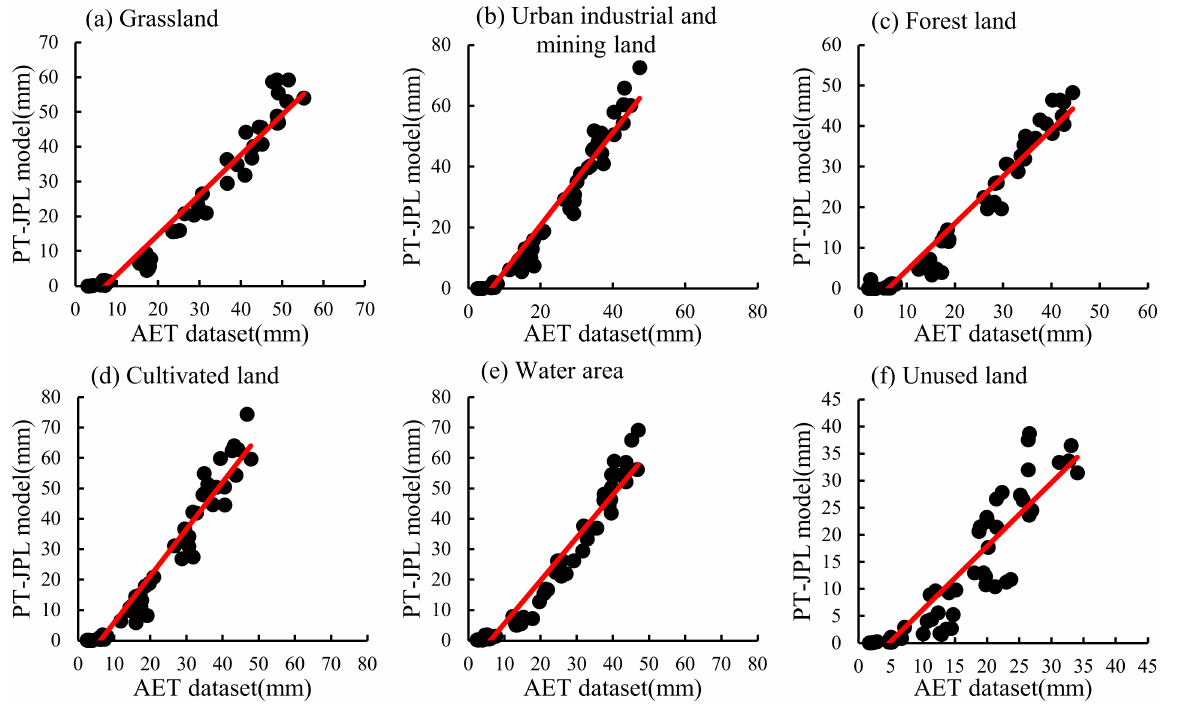
Figure 2. Comparison of the evapotranspiration of different land-use types between the AET dataset and the PT-JPL model. ( a – f ) describe the comparison of evapotranspiration in grassland, urban industrial and mining land, forest land, cultivated land, water area, and unused land, respectively. Table 2. Error statistics of the PT-JPL